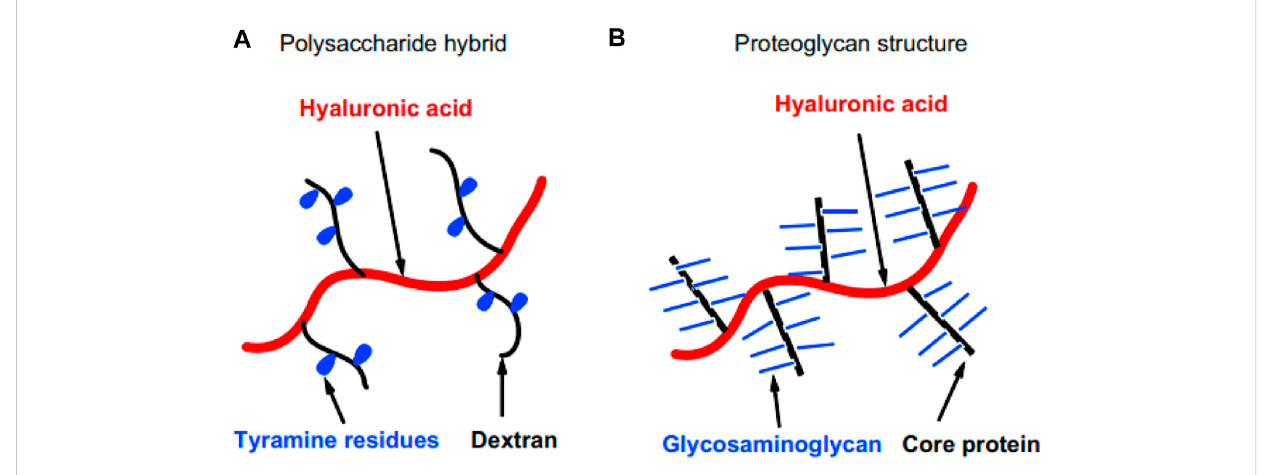
FIGURE 8 Schematic illustration of (A) the molecular structure of the material and its similarity to (B) proteoglycan of cartilage